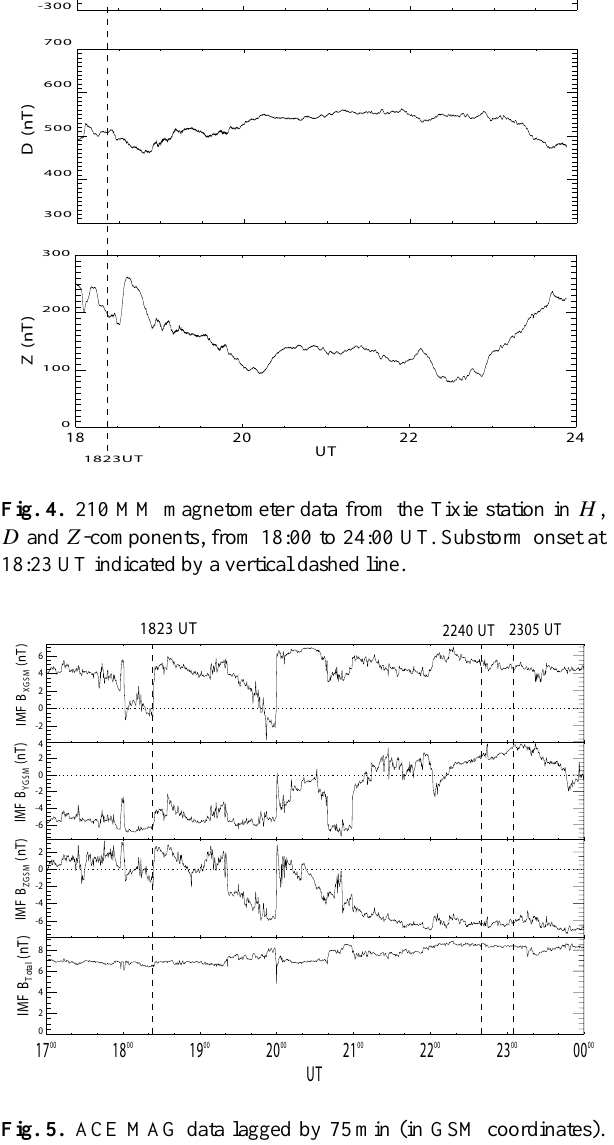
Fig. 5. ACE MAG data lagged by 75min (in GSM coordinates). Expansion phase onsets at 18:23 UT and 23:05 UT and a pseudo- breakup at 22:40 UT are indicated by vertical dashed lines.